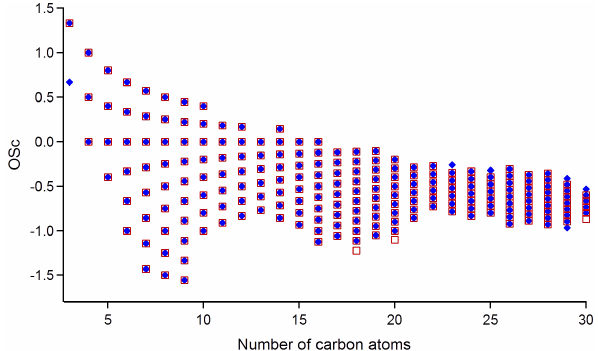
Figure 2. Carbon oxidation state of SOA from BVOC mixture from dark aging experiments with O 3 . Blue diamonds correspond to molecules in fresh SOA, red squares to aged SOA for